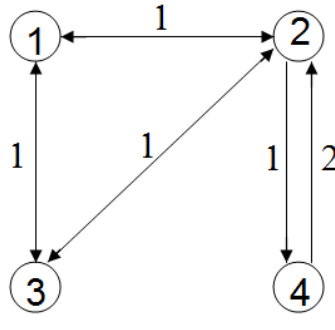
Figure 1. A communication network G over n = 4